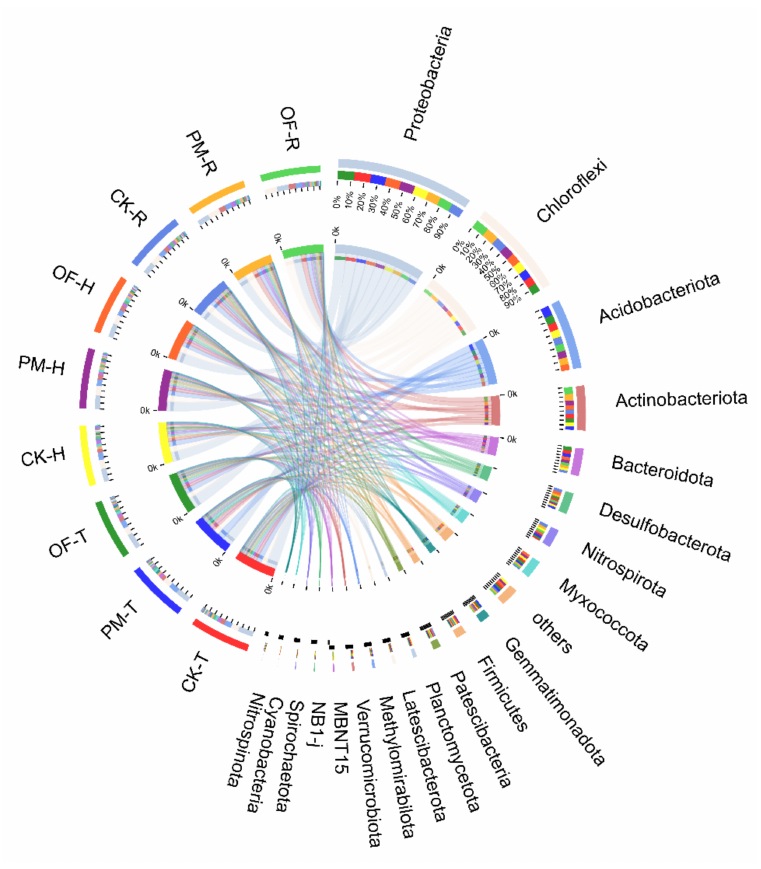
Figure 3. The relative abundance of microorganisms on phylum and genus levels with different